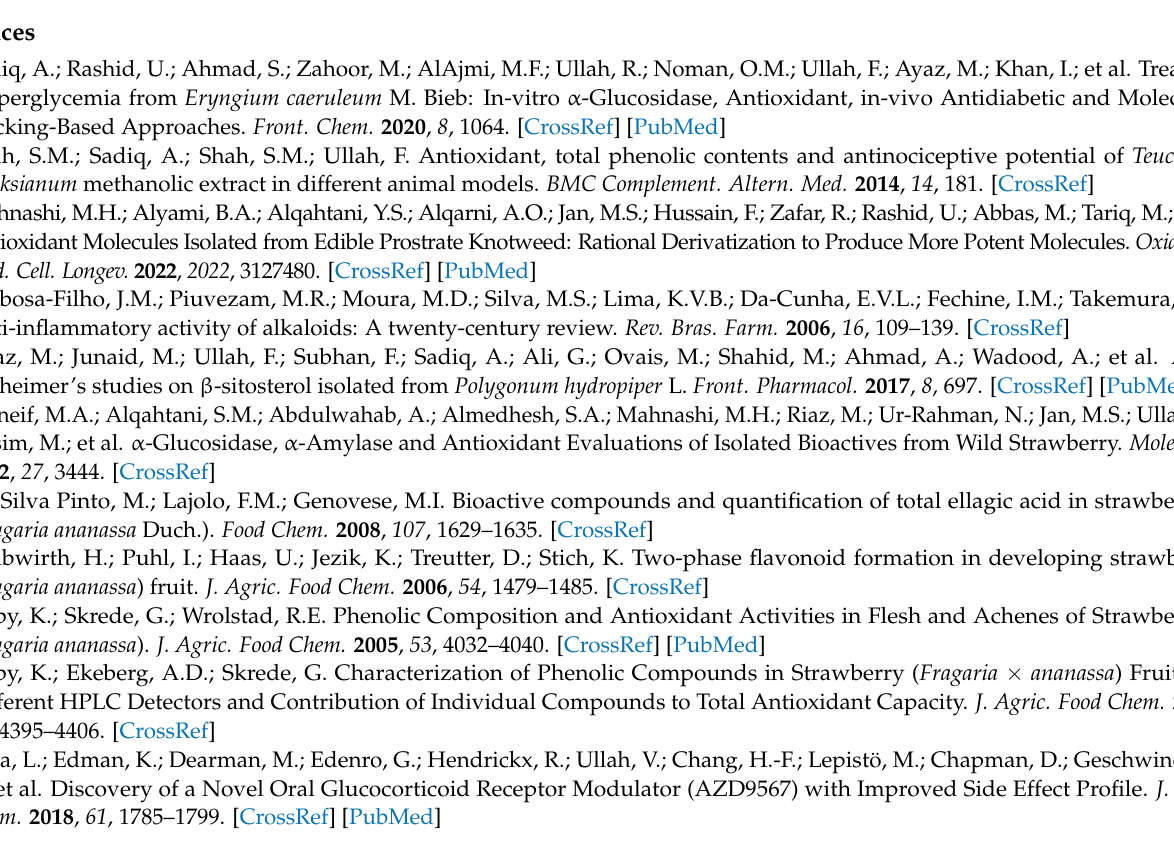
compound. Figure S2: GC-MS chromatogram of compound 1. Figure S3: MS spectrum and integration pattern of compound 1. Figure S4: MS zoomed spectrum of compound 1. Table S2: MS spectrum peak list of compound 1. Figure S5: Library spectrum of compound 1. Figure S6: Difference spectrum of compound 1. Figure S7: 1 H NMR spectrum of compound 2. Table S3: GC-MS details of compound 2. Figure S8: GC-MS chromatogram of compound 2. Figure S9: MS spectrum of compound 2. Figure S10: Zoomed spectrum of compound 2. Table S4: MS spectrum peak list of compound 2. Figure S11: Library spectrum of compound 2. Figure S12: Difference spectrum of compound